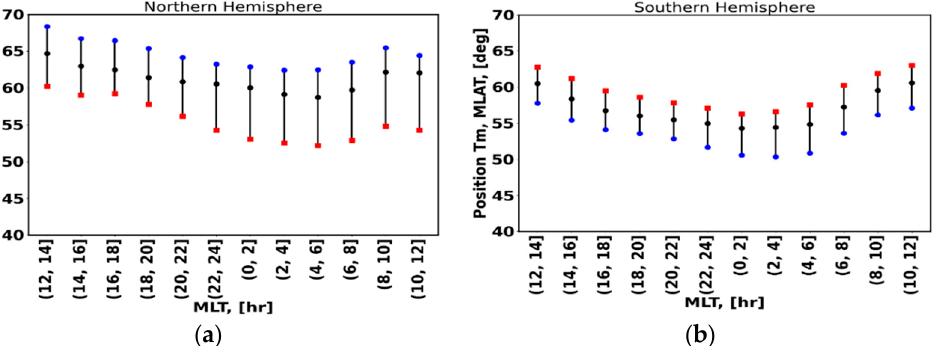
Figure 13. Diurnal variation in trough position for the northern ( a ) and southern ( b ) hemispheres as a function of the magnetic local